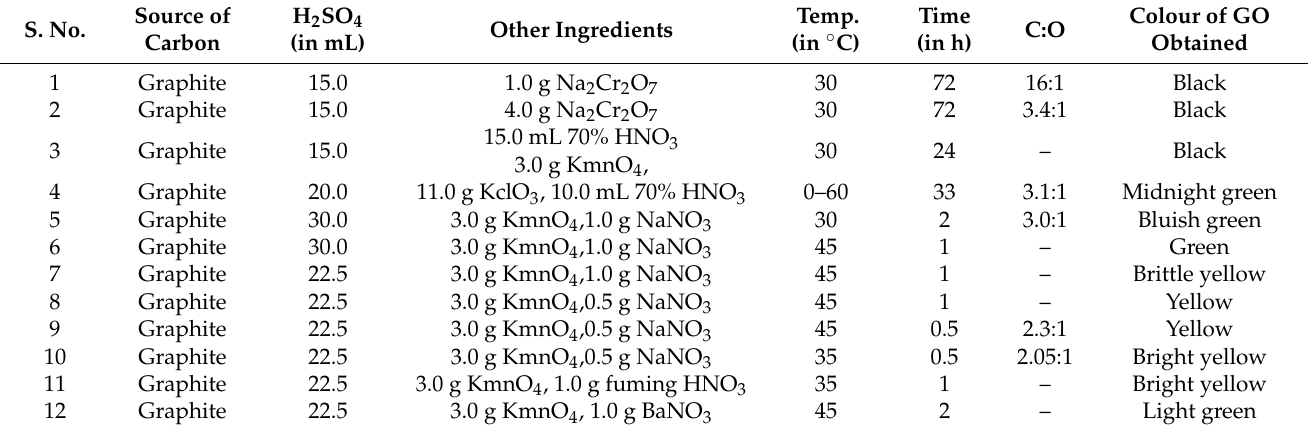
Table 3. Effect of acid concentration, reaction temperature, reaction time, and the quantity of the oxidizing agent on the oxidation of graphene